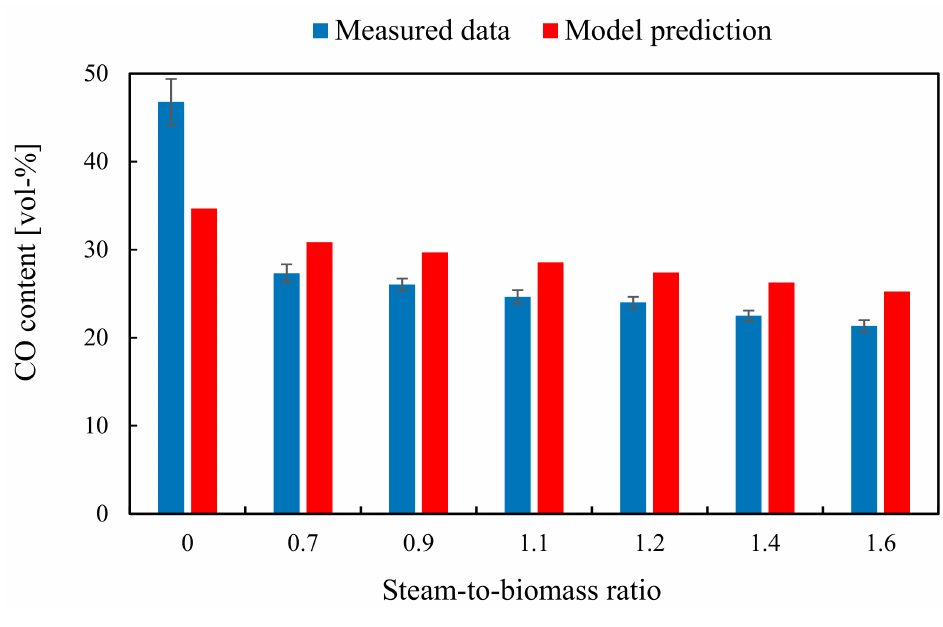
Figure 9. Effect of SBR on carbon monoxide content.